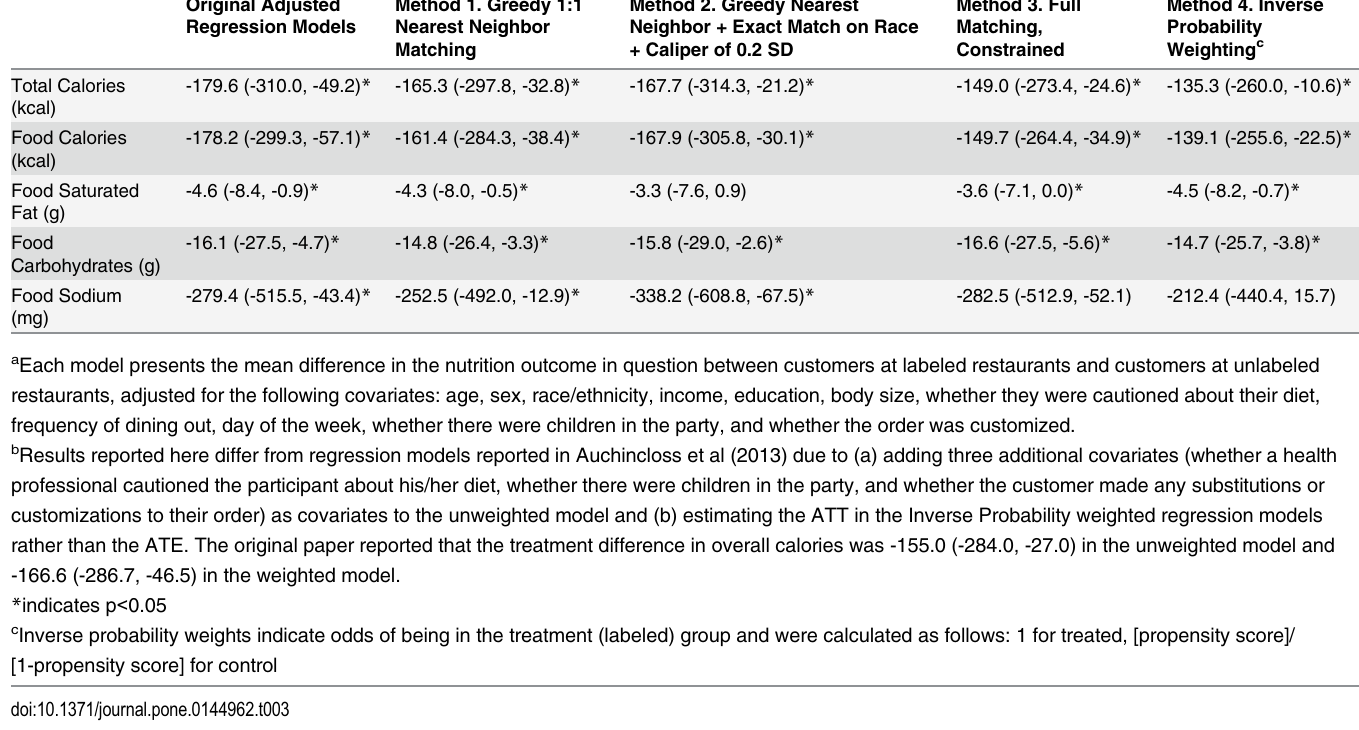
Table 3. Effect of Menu Labeling on Nutritional Outcomes a Before and After Propensity Score Matching/Weighting b . Original Adjusted Regression